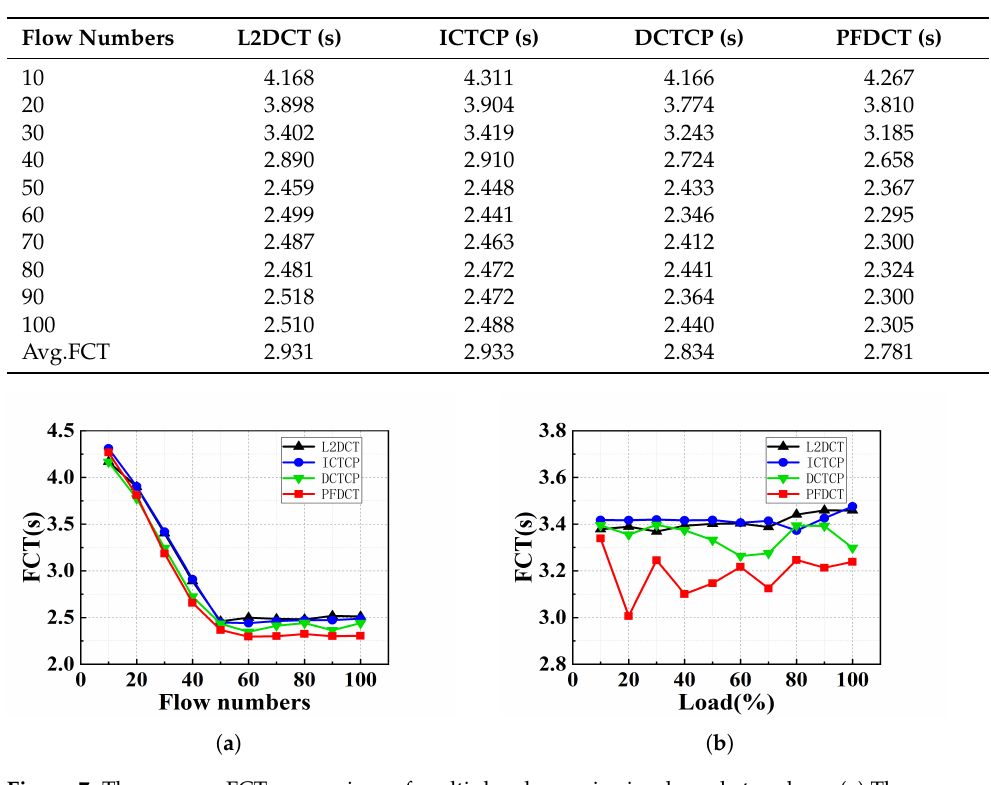
Figure 7. The average FCT comparison of multiple schemes in simple-scale topology. ( a ) The average FCT comparison with varying flow numbers sending 1500 KB flows. ( b ) The average FCT comparison with varying load sending 1500KB flows.